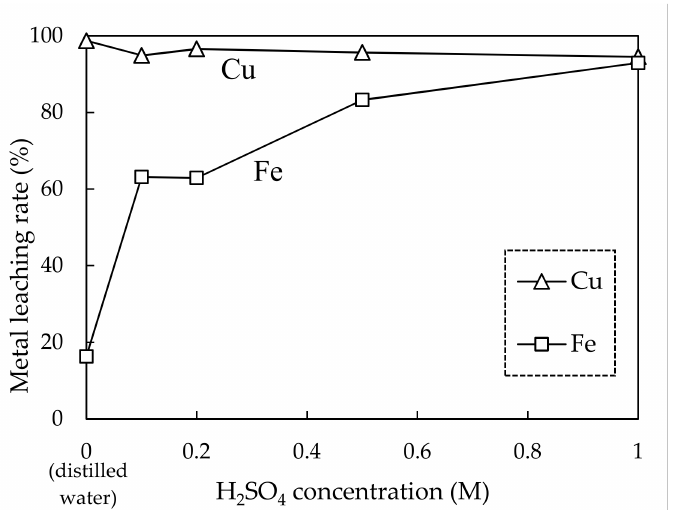
Figure 4. Effect of sulfuric acid concentration on the leaching rate of copper and iron. (Conditions: 100 g/L, 1 h, 700 rpm, 180 ◦ C, 2.0 MPa total